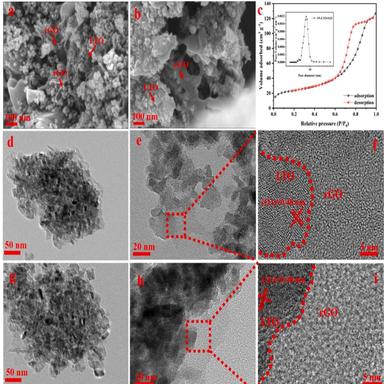
SEM images of (a) LTO/rGO, (b) SN-LTO/rGO; (c) N2 adsorption and desorption isotherms of SN-LTO/rGO (the inset in (c) presents the pore size distribution); TEM and HRTEM images of (d, e, f) LTO/rGO, (g, h, i) SN-LTO/rGO.